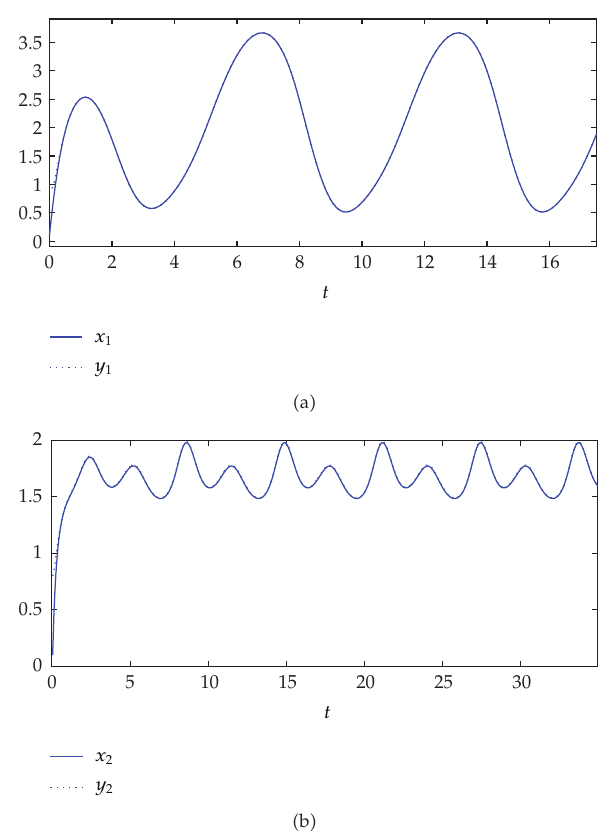
Figure 2: Complete synchronization of coupled systems (cid:6) 4.1 (cid:7) and (cid:6) 4.2 (cid:7) .